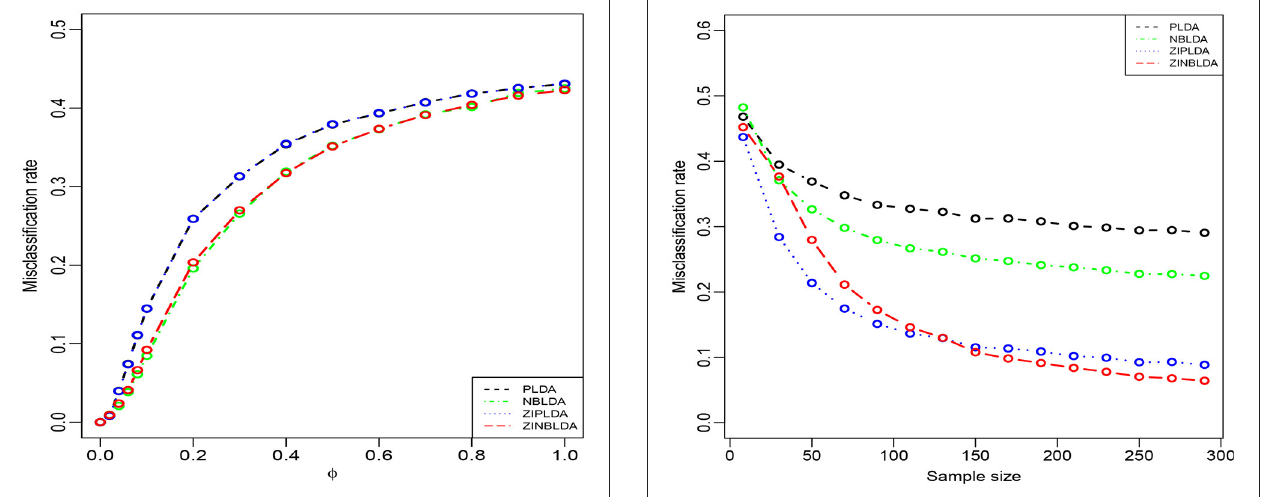
FIGURE 2 | The misclassification rates of the four methods with different dispersions (Study 1). Here, σ = 0.2, p = 100, n = 50, p 0 = 0, and DE rate = 0.2.